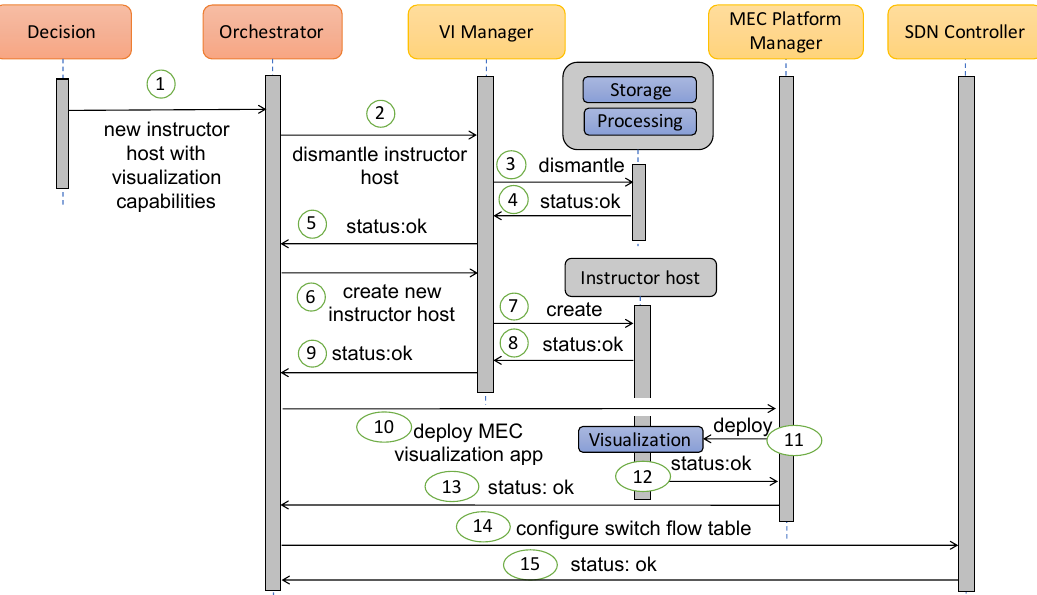
Figure 3. Architecture dismantling an old MEC Host, and deploying a new MEC Host and MEC